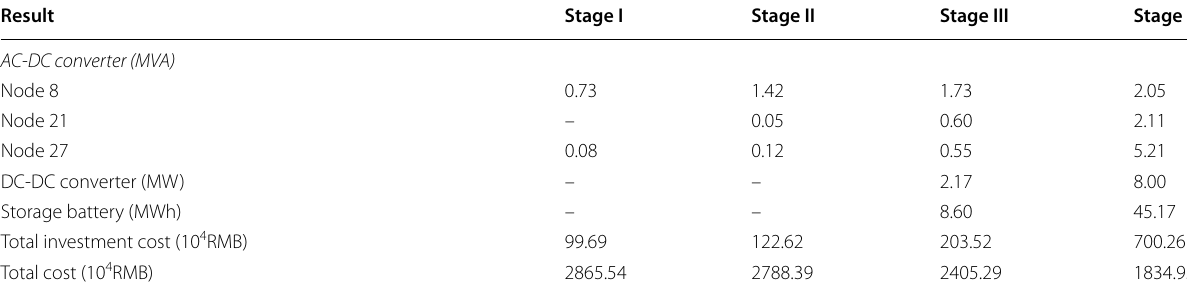
Table 8 Multi-stage planning results in Case